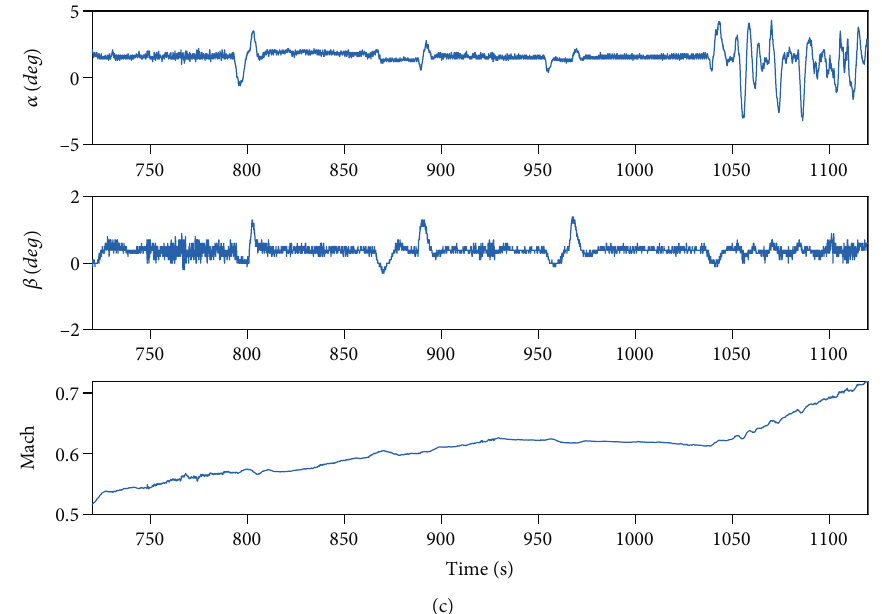
Figure 19: Flight test data. (a) Command and response value of the roll channel. (b) Command and response values of the yaw channel. (c) Response of other states. Table 9: RMS of the tracking error for fl ight test and simulation.